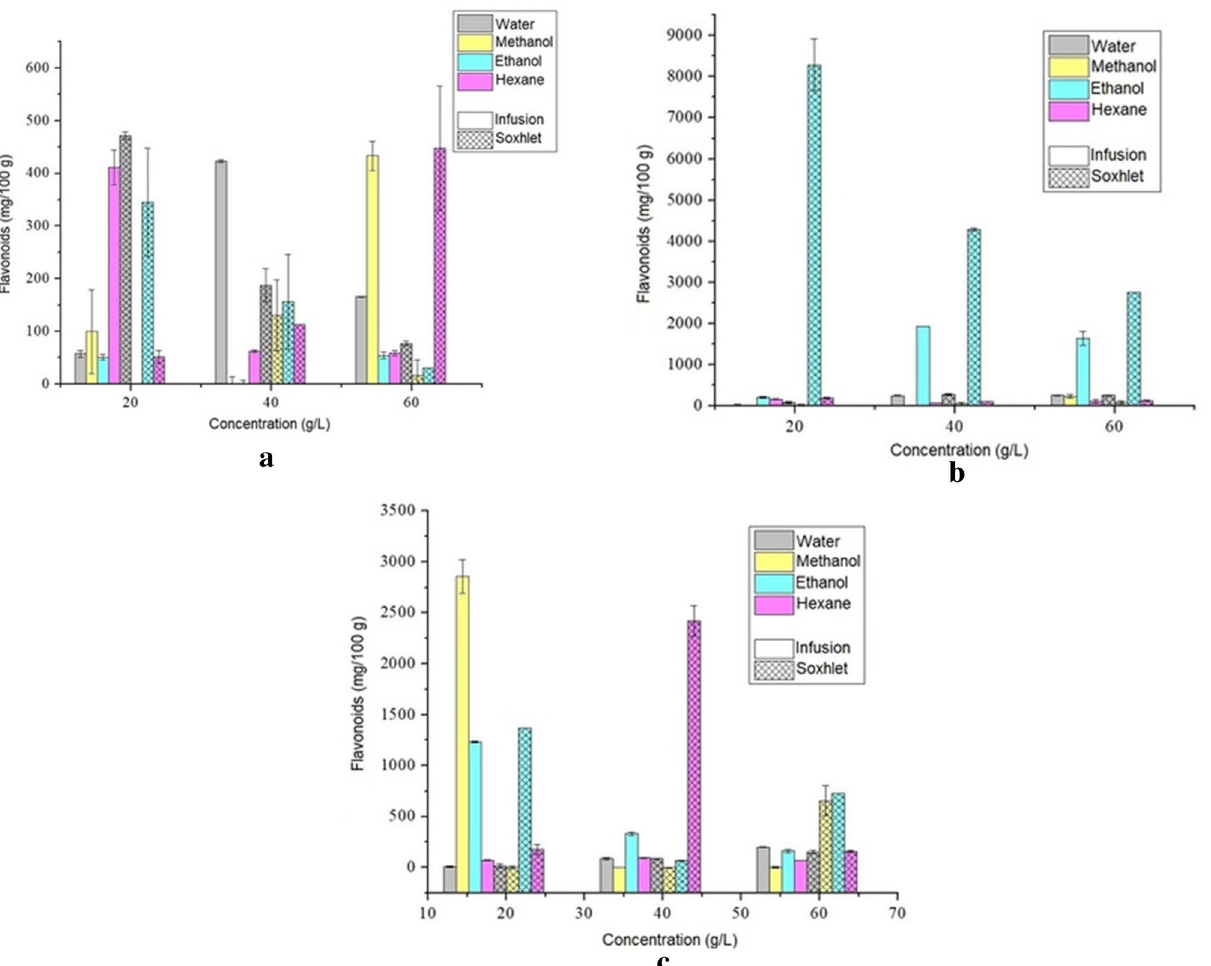
Figure 6. Total flavonoids concentration using 2 h ( a ), 4 h ( b ), and 6 h ( c ) as extraction